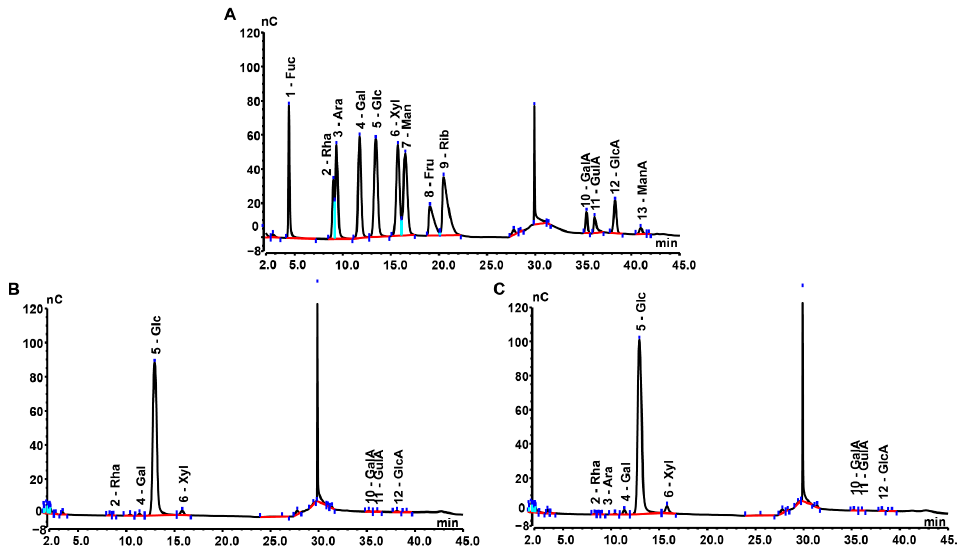
Figure 1. High-performance anion-exchange chromatography of monosaccharide compositions. ( A ) Monosaccharide standards, ( B ) MPS, and ( C ) Se-MPS.